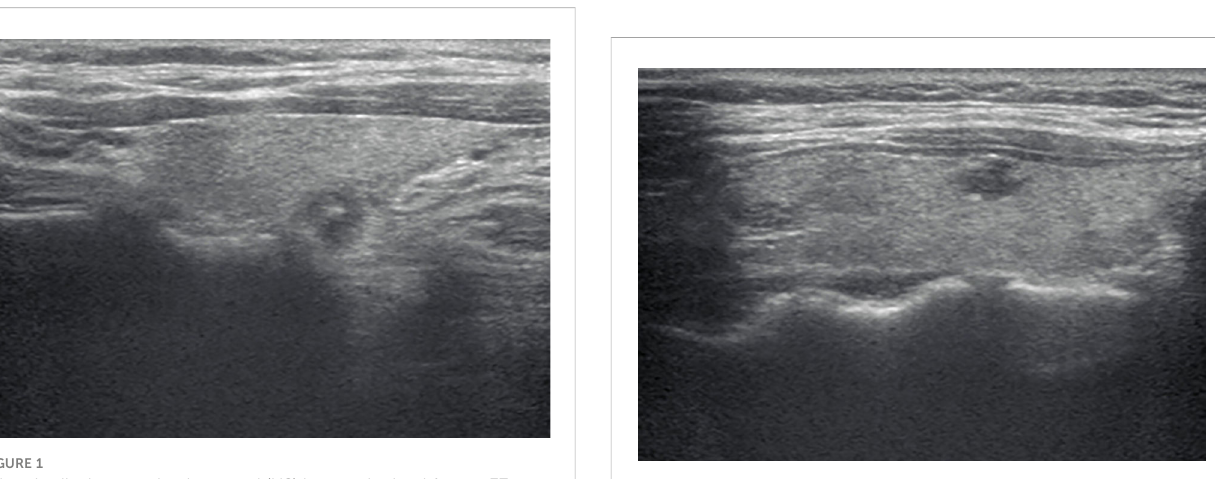
FIGURE 2 A longitudinal grayscale US image obtained from a 32-year-old woman with papillary thyroid carcinoma shows an 8 mm solid, hypoechoic, and irregular margin thyroid nodule. This nodule was classi fi ed as TR4C according to the Kwak TIRADS and TR4B according to the C TIRADS. The original TIRADS does not recommend biopsy, while the modi fi ed TIRADS suggests